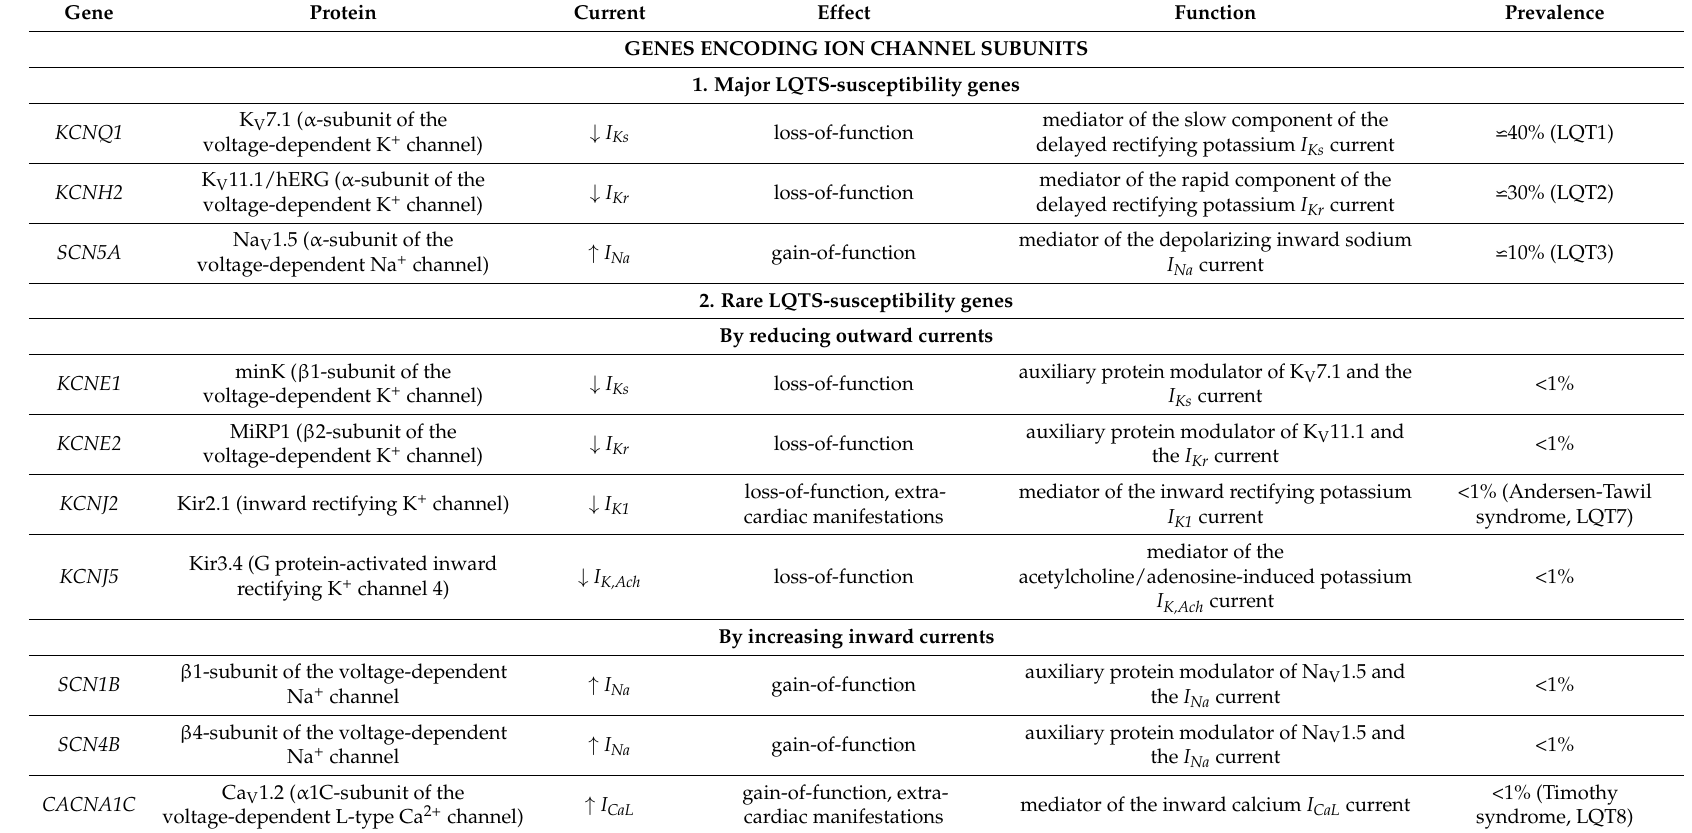
Table 1. Mutations associated with the